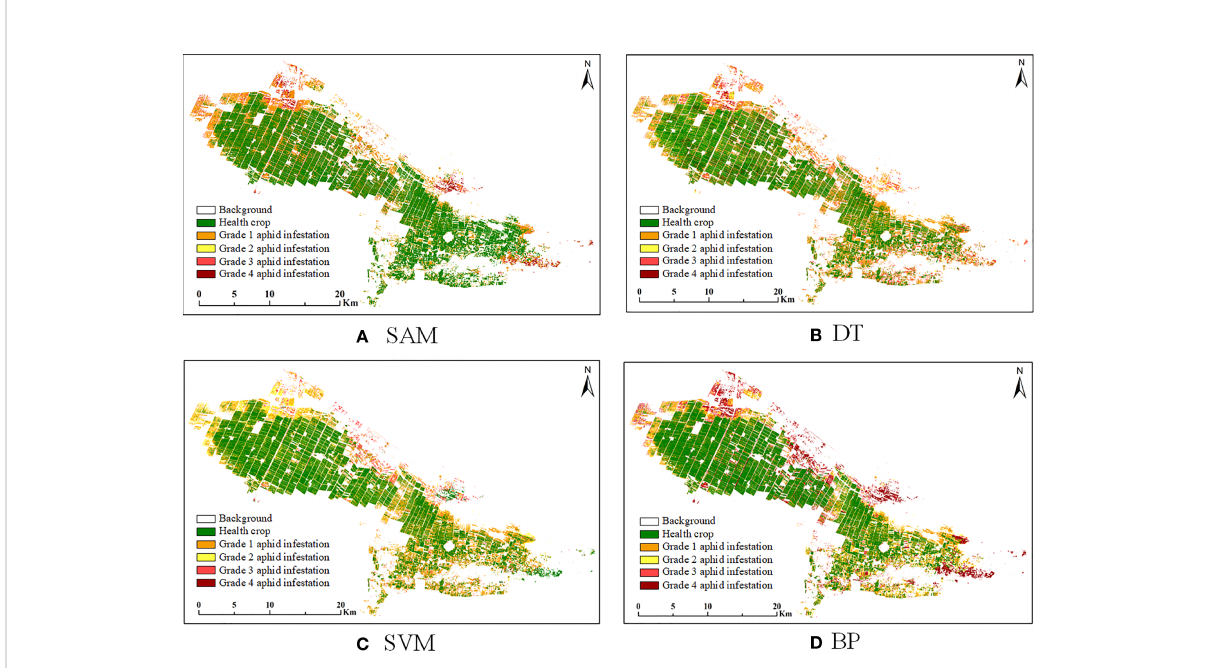
FIGURE 11 Classi fi cation results of four algorithms for cotton aphid infestation at different grades in the study area. (A) SAM, (B) DT, (C) SVM, (D) BP.